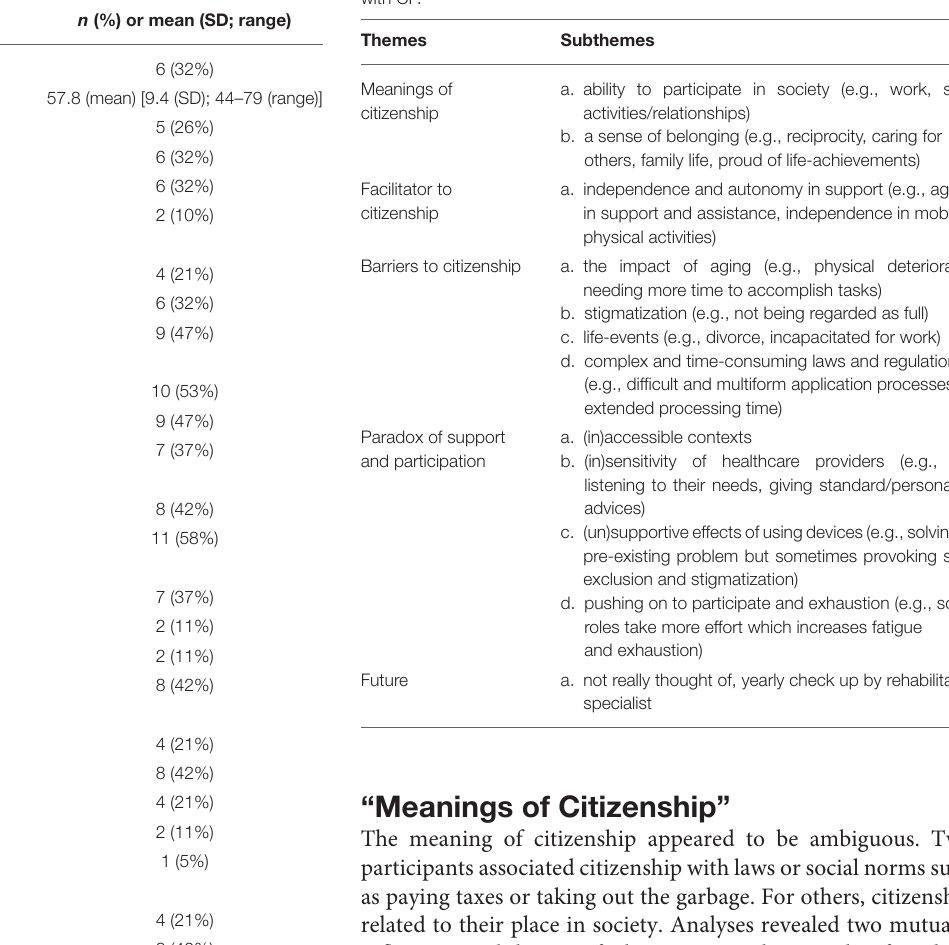
TABLE 1 | Characteristics of the sample ( n = 19) of adults with CP. TABLE 2 | Summary of the themes and subthemes found in this study of adults with